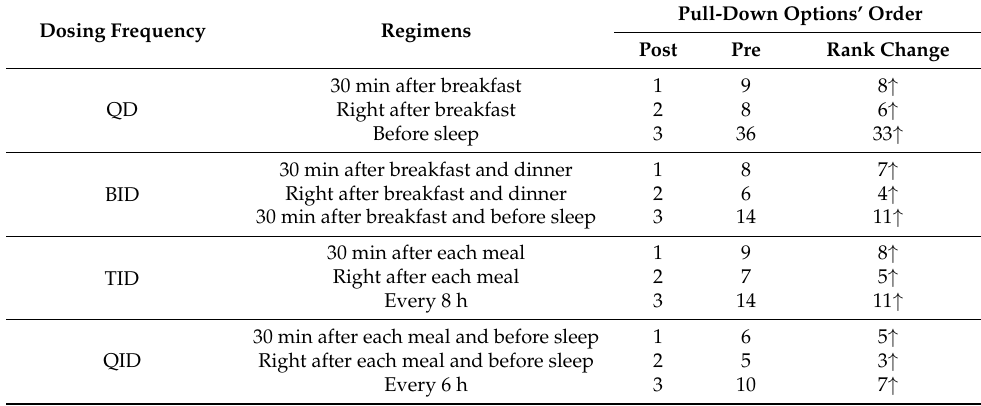
Table 3. Prioritization of the top three prevalent regimens by dosing frequency on the CPOE screen. Dosing Frequency